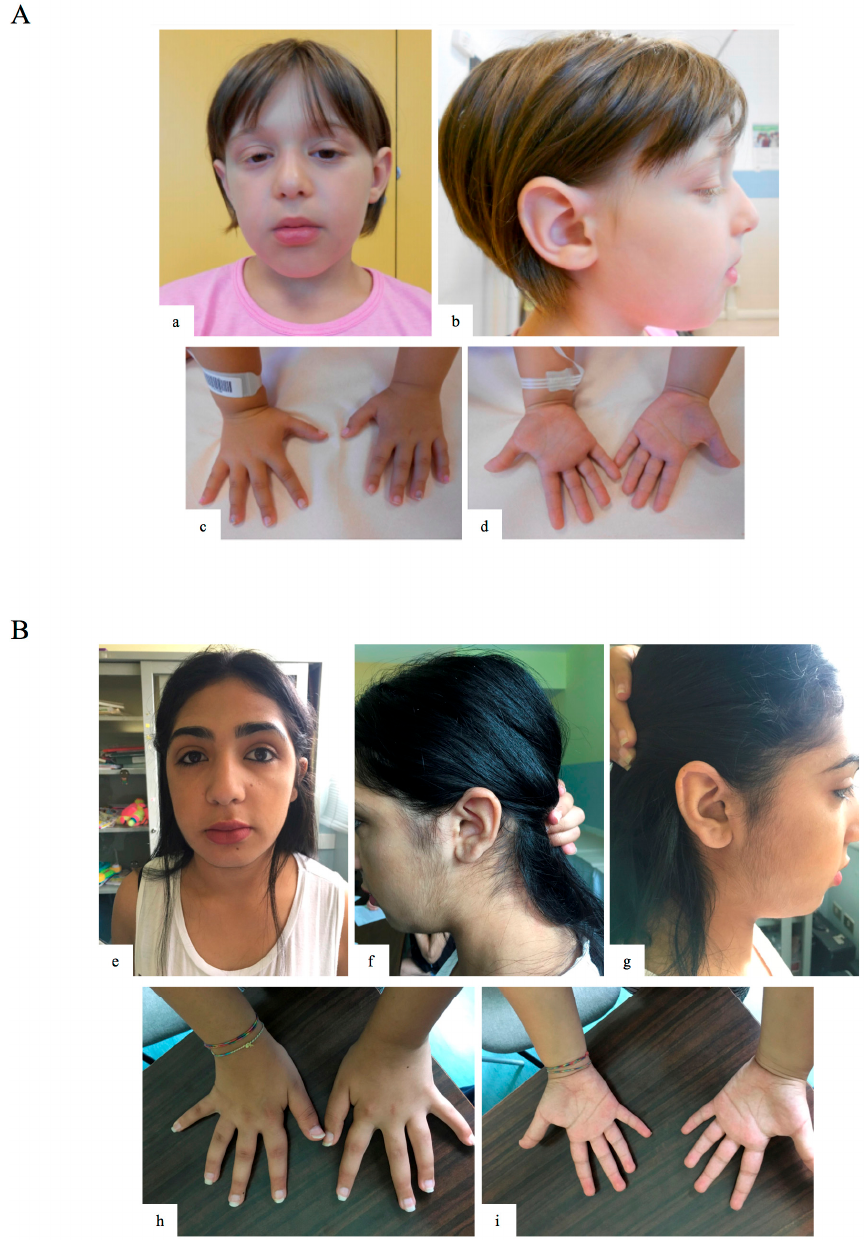
Figure 1. Clinical features of patients 1 and 3. ( a , b ) Facial features of patient 1 (GM13-3816; c.15061C=/>T, p.R5021X heterozygous mosaic KTM2D mutation), including sparse lateral eyebrows, long palpebral fissures with thick eyelids, ptosis, flat philtrum, thick everted lips and large dysmorphic ears with abnormal helix and large pinna; ( c , d ) hypoplastic proximal phalanges of 4th fingers, clinodactylous 5th fingers, and tapering fingers; ( e – g ) facial features of patient 3 (KB 369; c.3596_3597=/del, p.L1199HfsX7 heterozygous mosaic KMT2D mutation), including sparse medial eyebrows, long palpebral fissures with thick eyelids, flat philtrum, and thick everted lips; ( h , i ) limb/skeletal anomalies with persistent fetal pads and clinodactylous 5th fingers, and tapering fingers. Patient 2 (KB450) is the female, first child of healthy non-consanguineous parents, with the mother 33 years old and the father 37 years old (Table 1). The family history was uneventful for